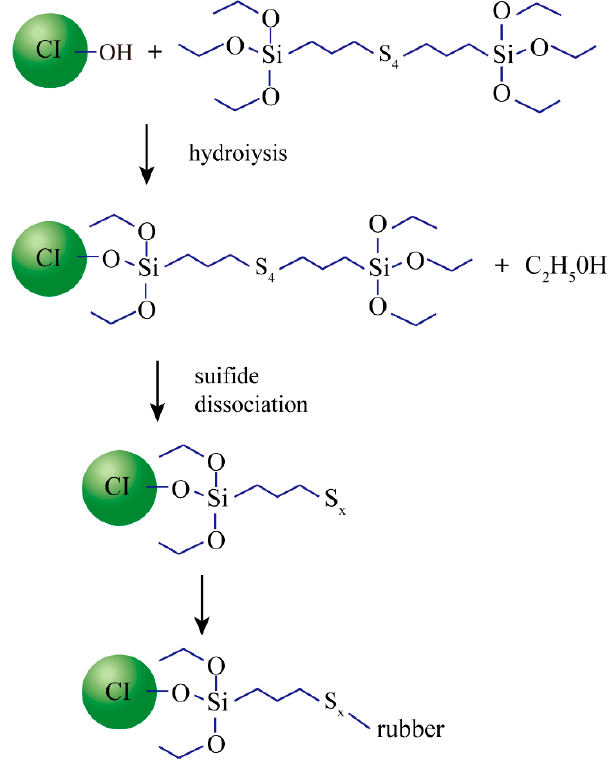
Figure 11. Illustration of the reaction mechanism of the silane coupling agent to form a chemical bond between the CI particles and rubber.